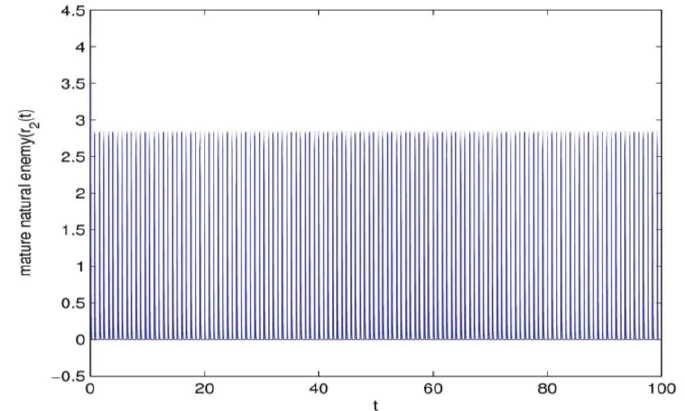
Figure 5. Periodic behaviour of (𝑟